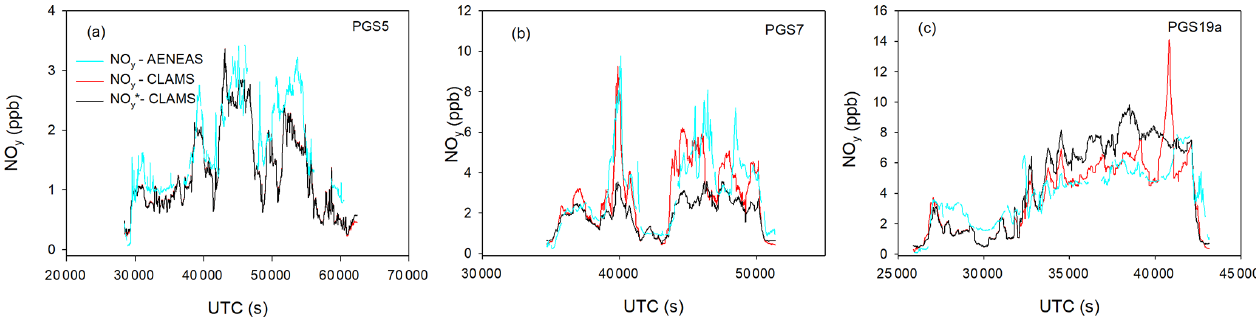
Figure 15. Comparison between observed NO y and simulated NO y values with the CLaMS model. Additionally, NO ∗ y calculated with CLaMS is given. Shown are examples for three POLSTRACC flights from the three observation phases. Early winter: PGS flight 5 – 21 December 2015, mid-winter: PGS flight 7 – 18 January 2016, late winter: PGS flight 19a – 13 March